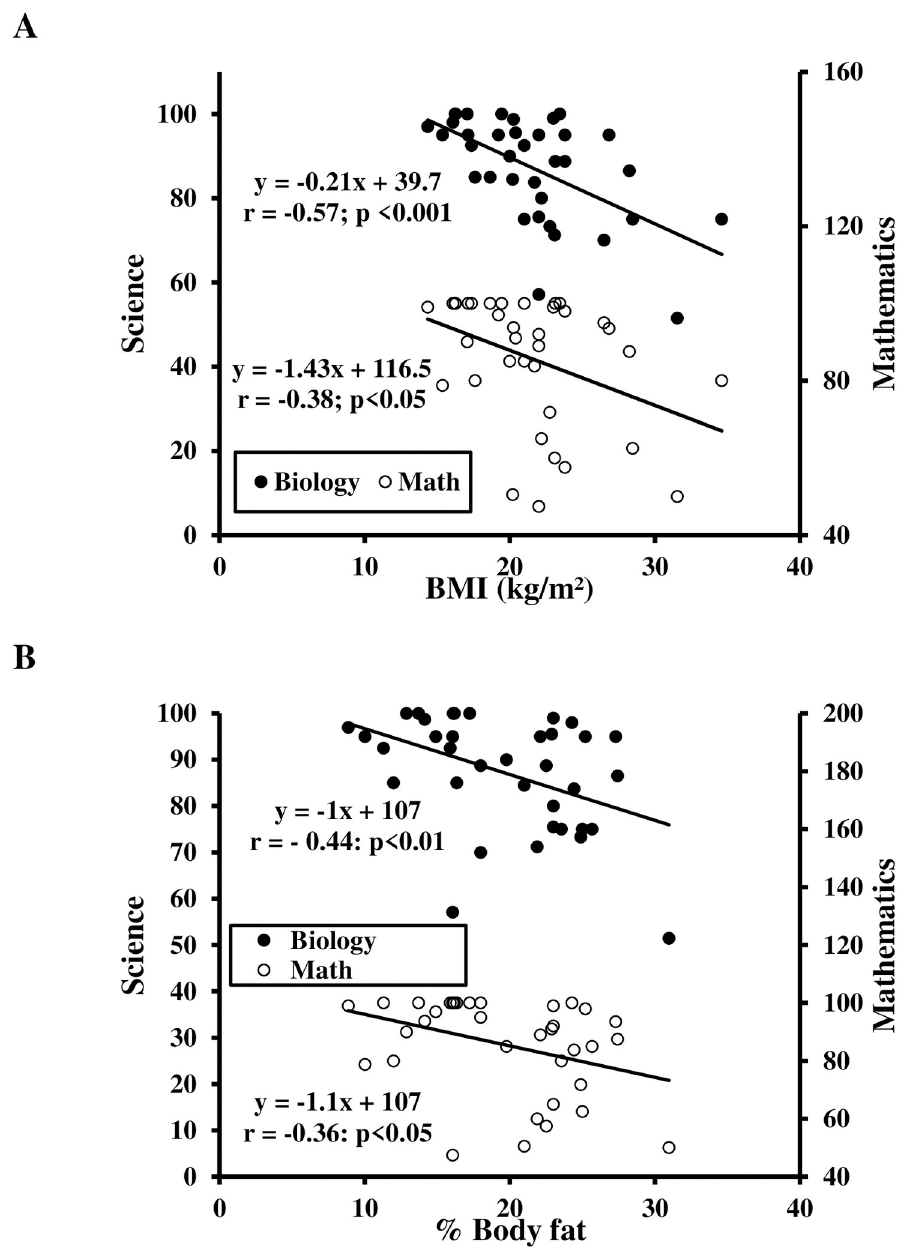
Fig 1. Relationship between body mass index (BMI) (A) and body fat (BF) (B) with science and mathematics scores.